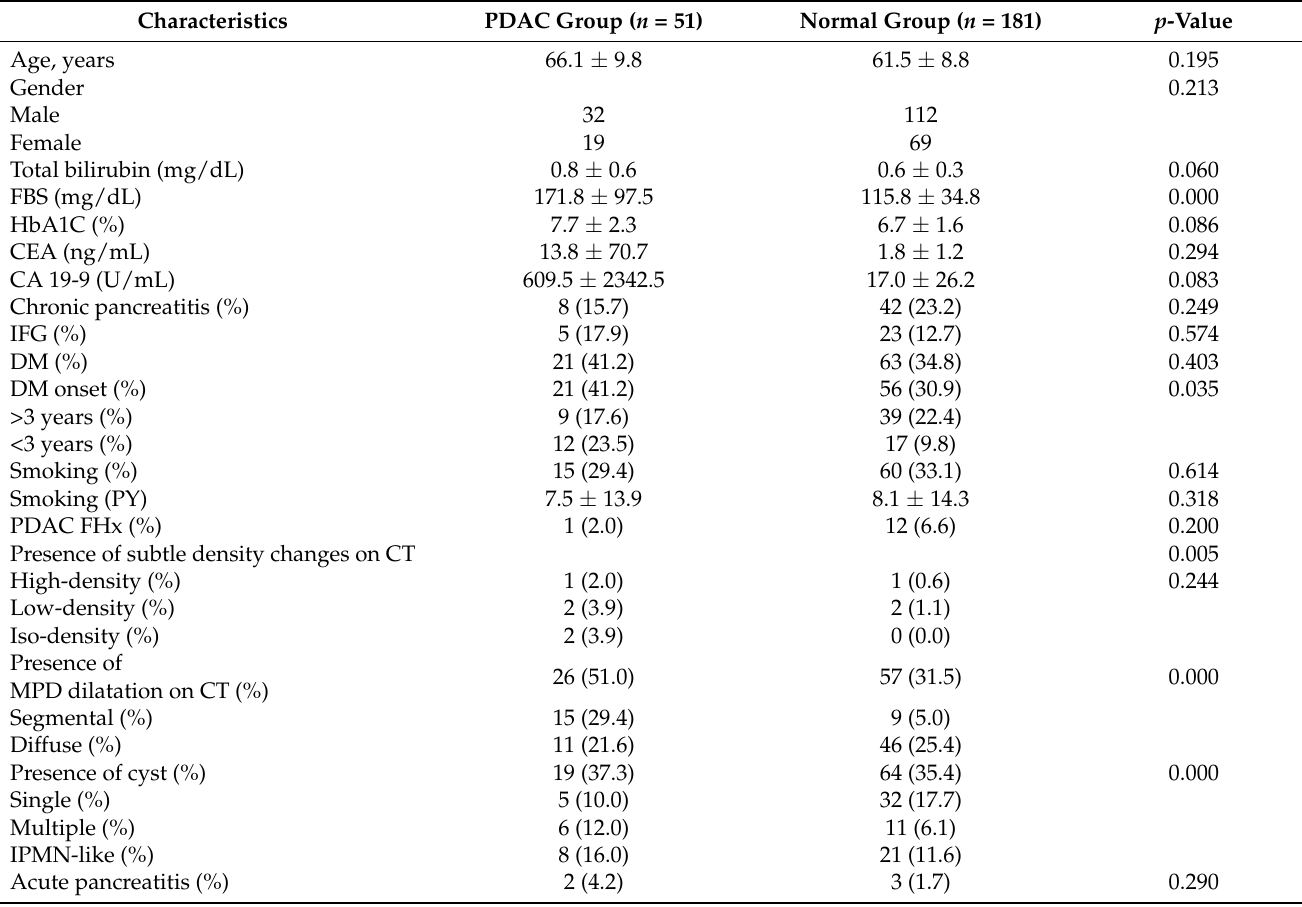
Table 1. Baseline characteristics in all study